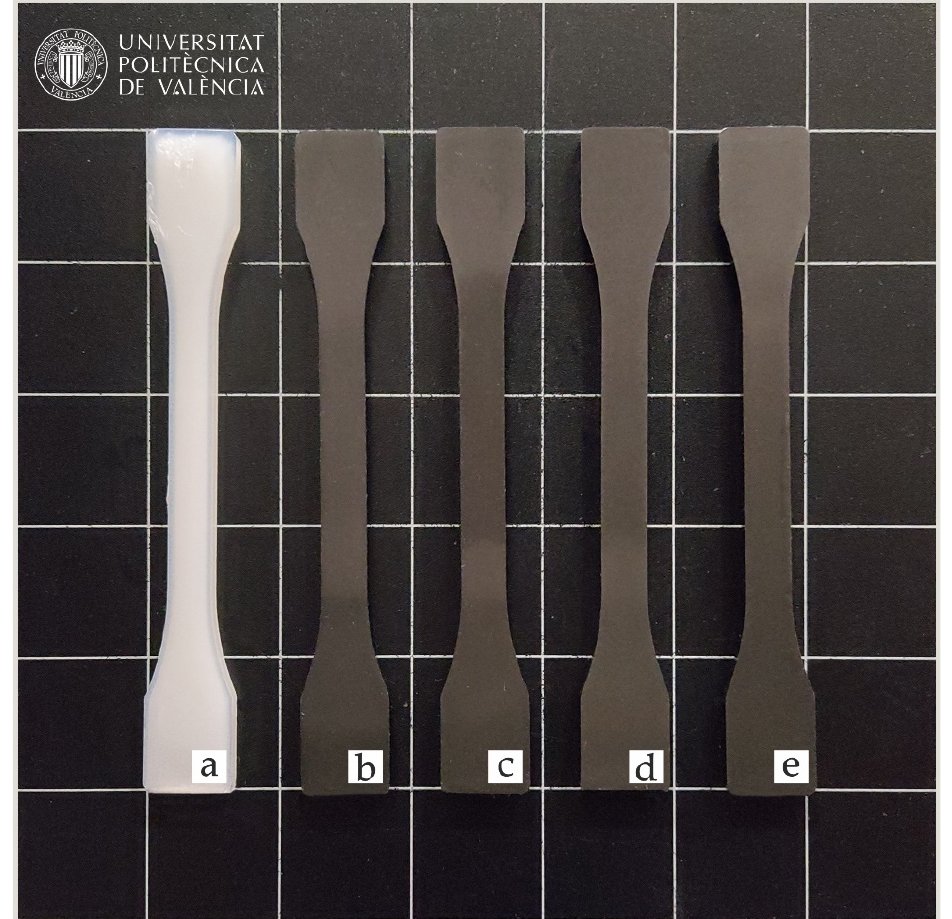
Figure 6. Visual appearance of the samples: ( a ) PA1010; ( b ) PA1010/2.5EGr; ( c ) PA1010/5EGr; ( d ) PA1010/7.5EGr; ( e ) PA1010/10EGr.